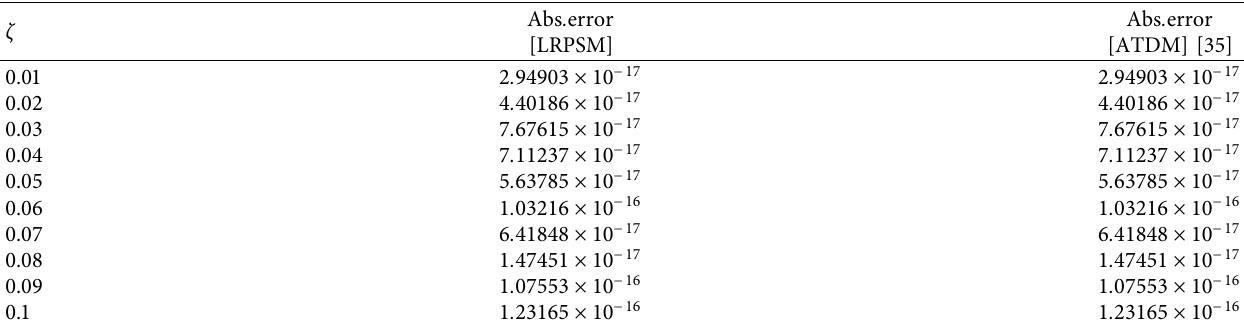
Table 14: | w ( ϰ , ζ ) − w 5 ( ϰ , ζ )| in diferent approaches for Problem 2 at ϰ � 1 . 0 when ϖ � 1 . 0 at plausible locations in the range ζ ∈ [ 0 , 0 . 1 ] .